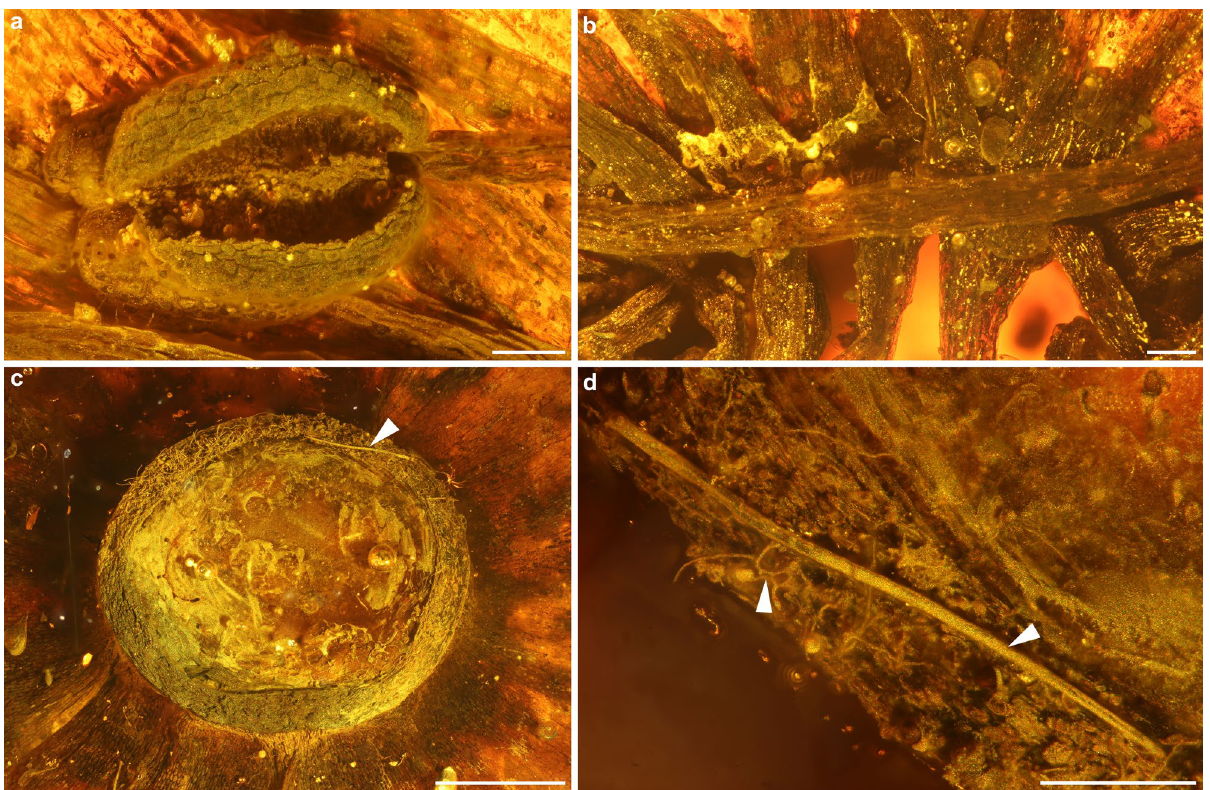
Figure 2. Details of Symplocos kowalewskii comb. nov. et emend. (Symplocaceae; X4088) from late Eocene Baltic amber. ( a ) Anther. ( b ) Basally fused and broadened filaments, arranged in three rows and forming a fused ring. ( c ) Underside of the fused staminate ring with trichomes (arrowhead). ( d ) Simple, long, acute trichome (right arrowhead), magnified from ( c ); left arrowhead indicates fungal hyphae. Scale bars 200 µm in ( a ), ( b ), ( d ); 1 mm in ( c